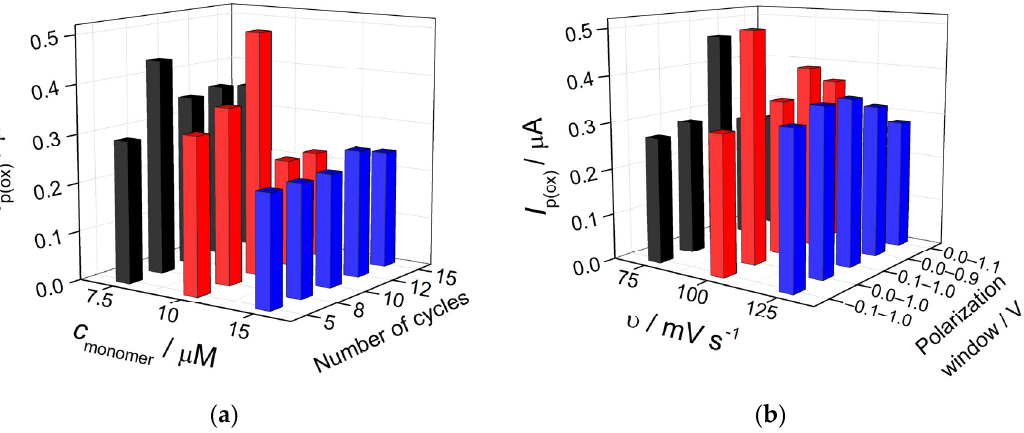
Figure 3. Effect of thymolphthalein electropolymerization conditions on the oxidation currents of 10 µ M thymol at the polymer-modified electrode using cyclic voltammetry: ( a ) effect of the monomer concentration and number of scans; ( b ) effect of the electrolysis parameters (polarization window and potential scan